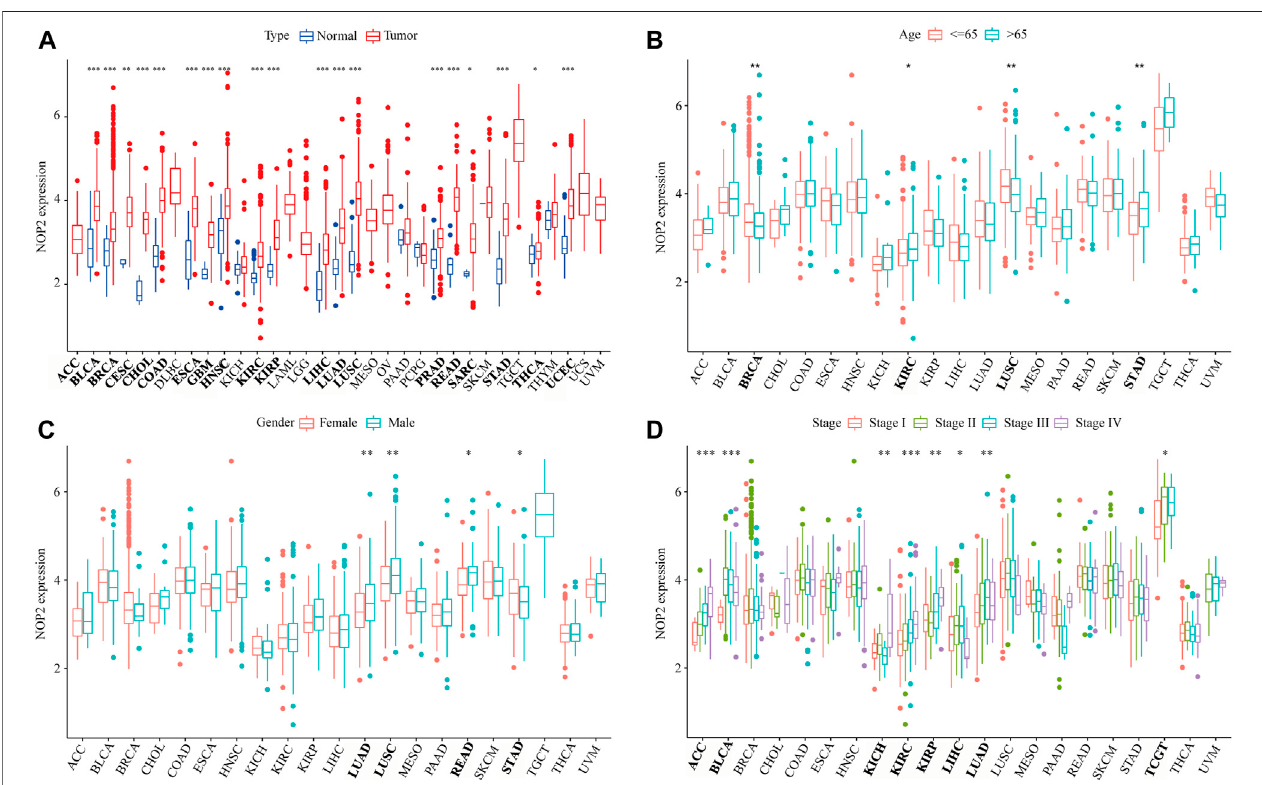
FIGURE1| Correlationbetweenclinicalcharacters andNOP2 expressionin33humancancers. (A) Differentialexpression analysisbetweenthetumor andnormal groups of NOP2; (B) correlation between age and NOP2; (C) correlation between gender and NOP2; and (D) correlation between tumor stage and NOP2 (* p < 0.05; ** p < 0.01; and *** p <